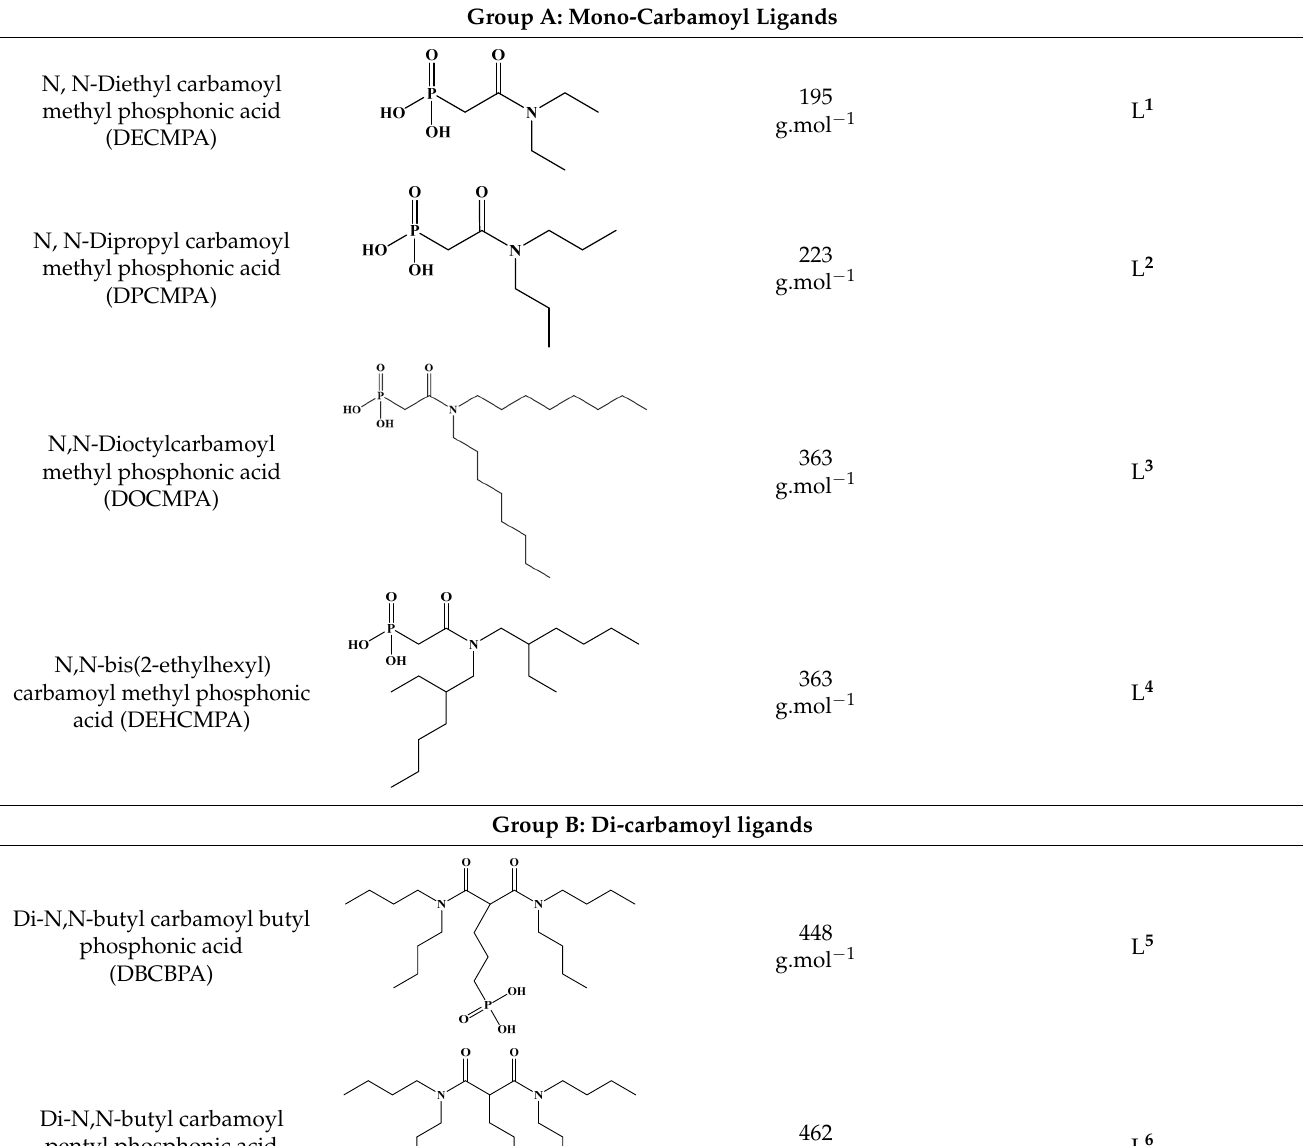
Table 1. Structures of the selected carbamoyl-based organic ligands to modify the nano-ZrO 2 surface. Group A: Mono-Carbamoyl Ligands